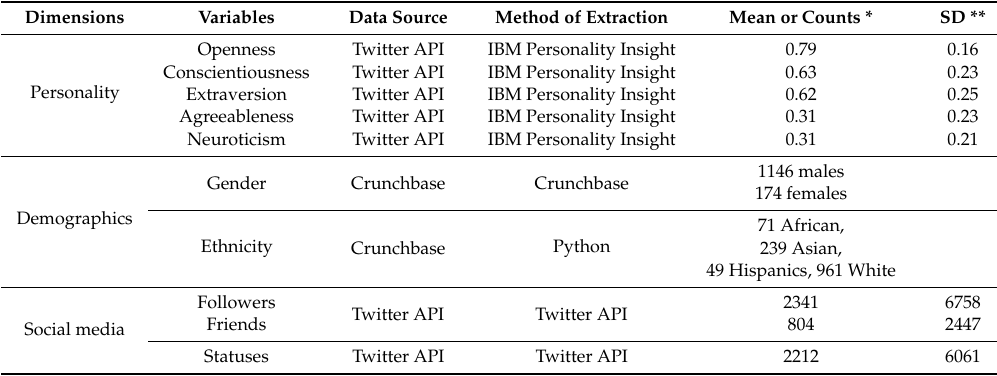
Table 1. Summary of